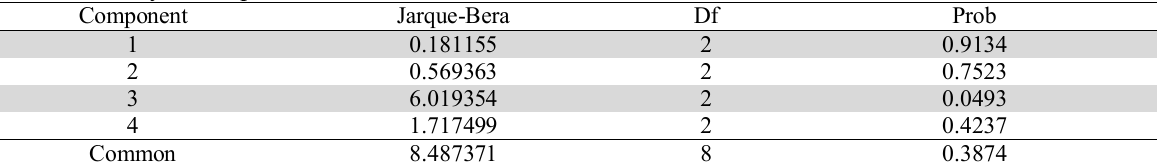
The summary of Jarqe-Bura